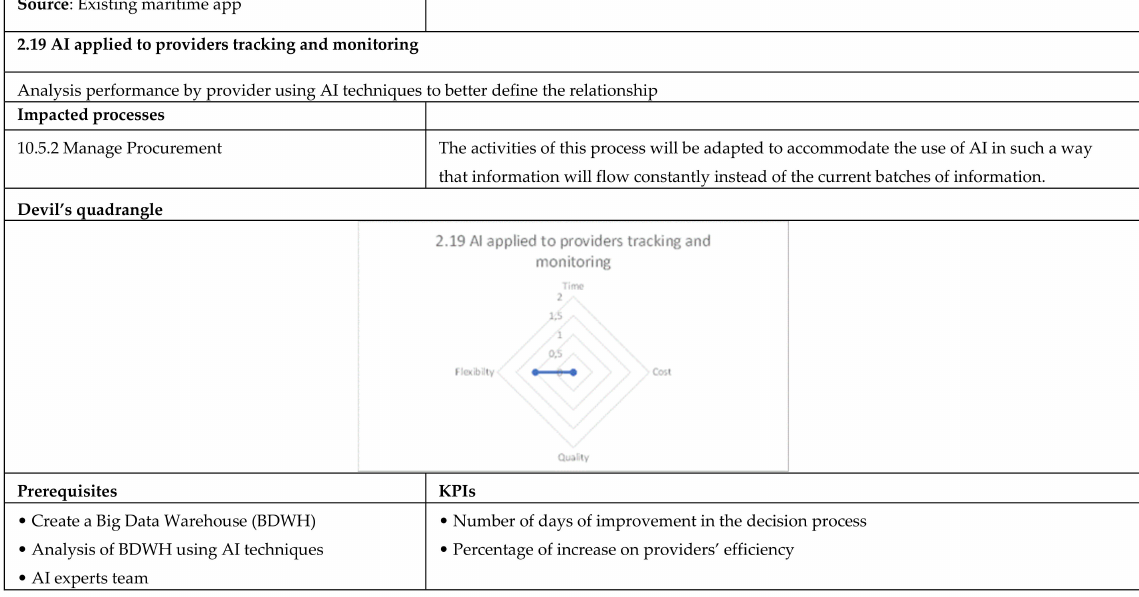
Figure A23. AI applied to providers tracking and monitoring data sheet.